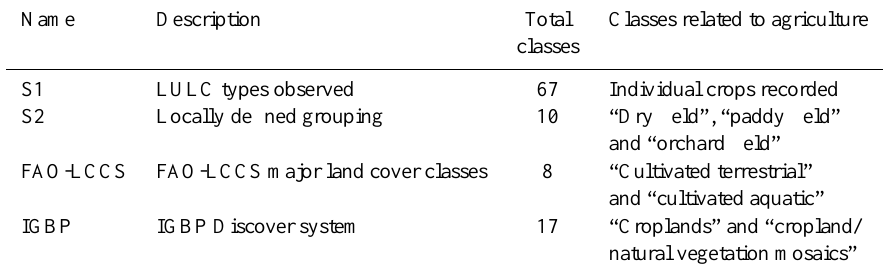
Table 2. Characteristics of the different land use and land cover classification